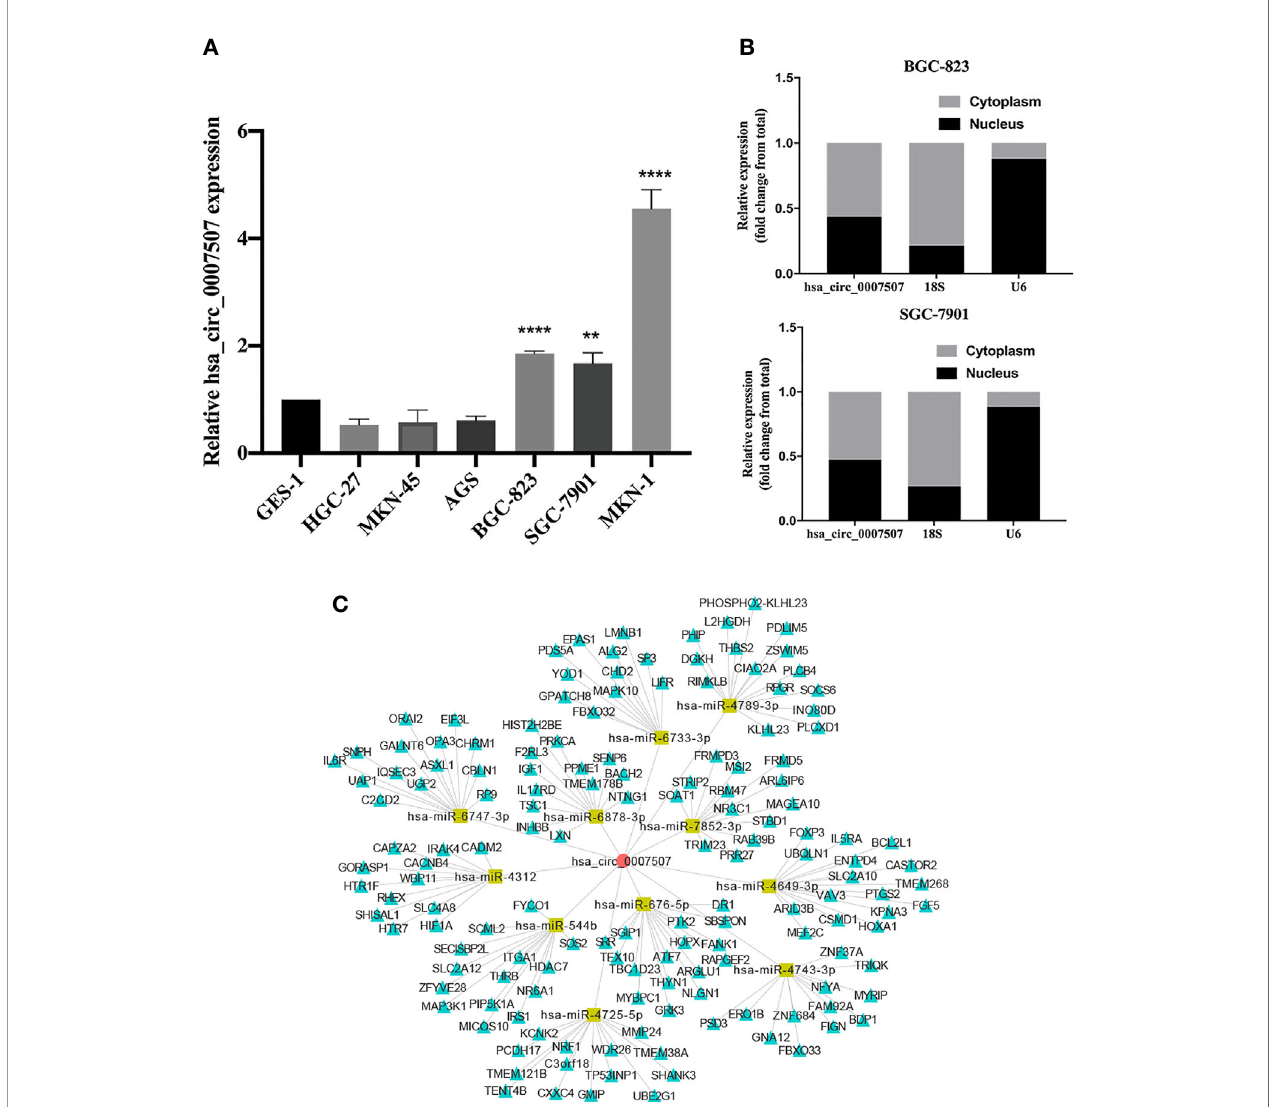
FIGURE 5 | Exploration of the downstream regulatory network of hsa_circ_0007507 in gastric cancer (GC) cells. (A) Detection of hsa_circ_0007507 expression in six GC cell lines. (B) Detection of hsa_circ_0007507 location in BGC-823 and SGC-7901 cell lines by nucleoplasm separation assays. (C) Prediction of circular RNA (circRNA)-microRNA (miRNA) – messenger RNA (mRNA) network map of hsa_circ_0007507. The red round shape represents hsa_circ_0007507, and the yellow rectangle represents eleven miRNAs that could interact with hsa_circ_0007507, while the green triangle represents the target mRNA of the corresponding miRNA. Indicated statistical signi fi cance (** p < 0.01, **** p <